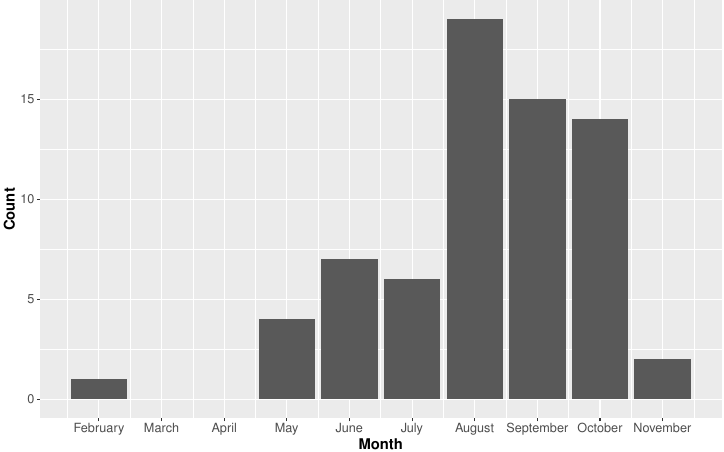
Figure 8. Monthly distribution for tropical cyclone (TC) rainfall in Miami, Florida showcasing the seasonality of TC